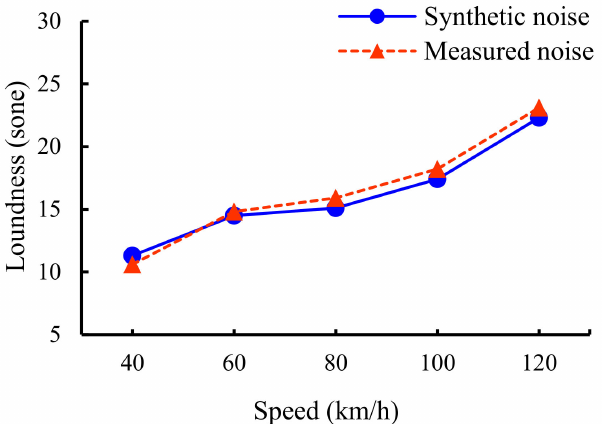
Figure 22. Comparison of synthetic and measured noise loudness at different operating speeds of the PEV.